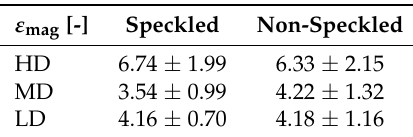
Table 3. Mean and standard deviation values of the equivalent strain magnification ( ε mag ) at the apparent ultimate point for speckle and non-speckle groups and the three densities analyzed.